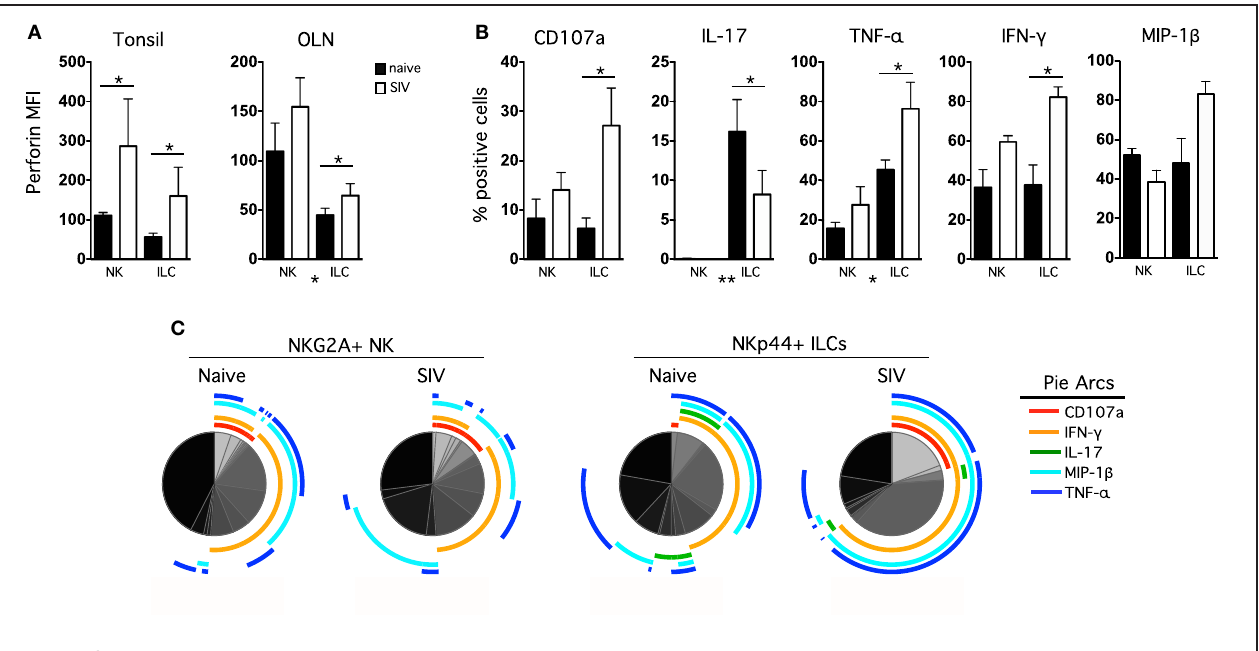
subpopulation were determined by expressing each response as a proportion of the total cell population. The means ± SEM for 6–8 animals per group are shown. (C) Multiparametric analyses were performed for each group using SPICE software (v.5.22). Mann–Whitney U -tests were used for naïve-vs.-SIV comparisons and Wilcoxon Matched Pairs tests were used to compare NK cells and ILCs; ∗ P < 0 . 05; ∗∗ P < 0 . 01. MFI, median fluorescence intensity; OLN, oral lymph